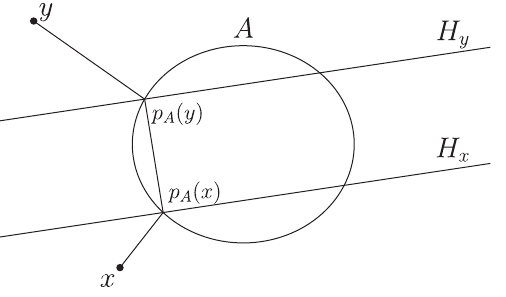
FIG. 10. The nearest-point projection p onto a compact set A (oval). Also depicted are the line segment connecting the two image points p two hyperplanes orthogonal to